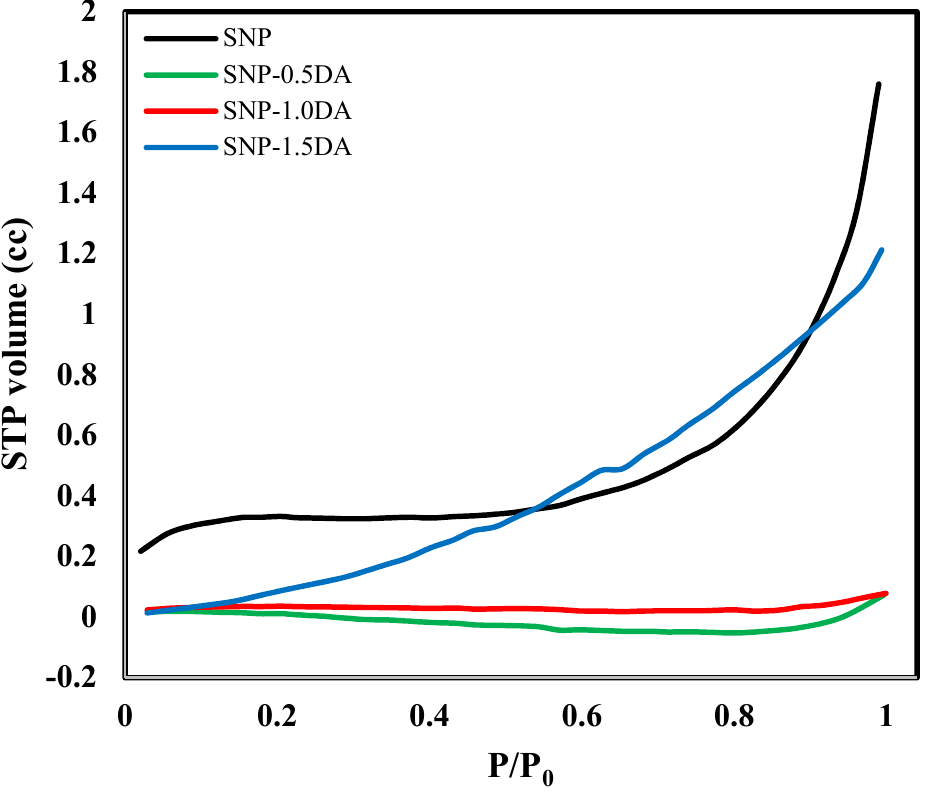
Figure 5. The nitrogen adsorption isotherms of the silica nanocomposites prepared with different amounts of DA.